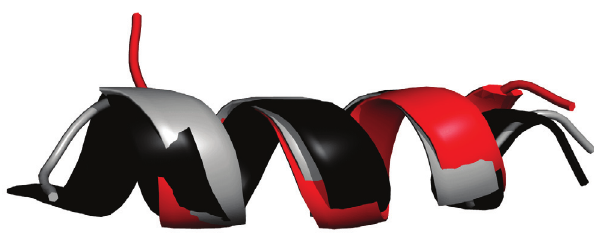
Figure 1. Superimposition of the amphipathic region of E2 (segment 689 to 703) in three molecular dynamics simulations. The most stable helical region of the E2 amphipathic segment during molecular dynamics simulations. 2KZQ in red, I-Tasser model in black and ideal helix model in gray.